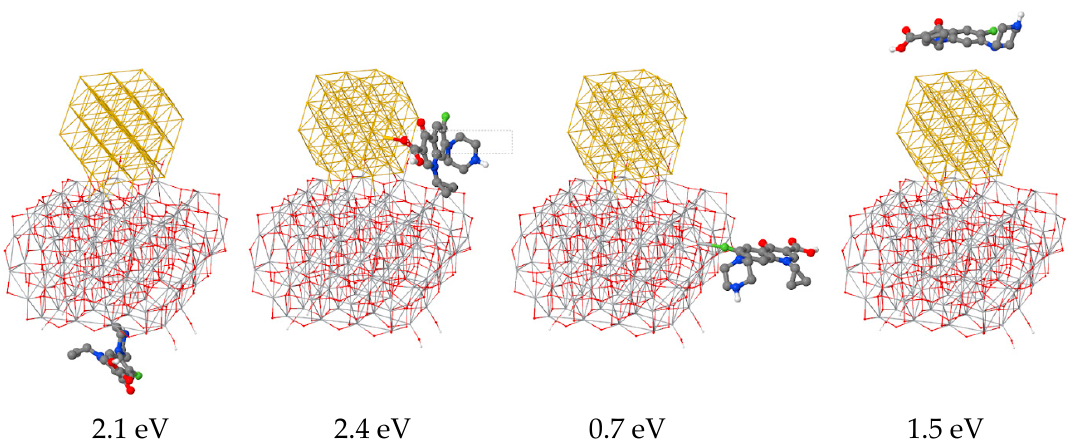
Figure 9. Four possible adsorption geometries of CIP on (Au 55 (TiO 2 ) 97 H 8 ) + 58 with corresponding binding energies. The positive binding energies indicate that the process is